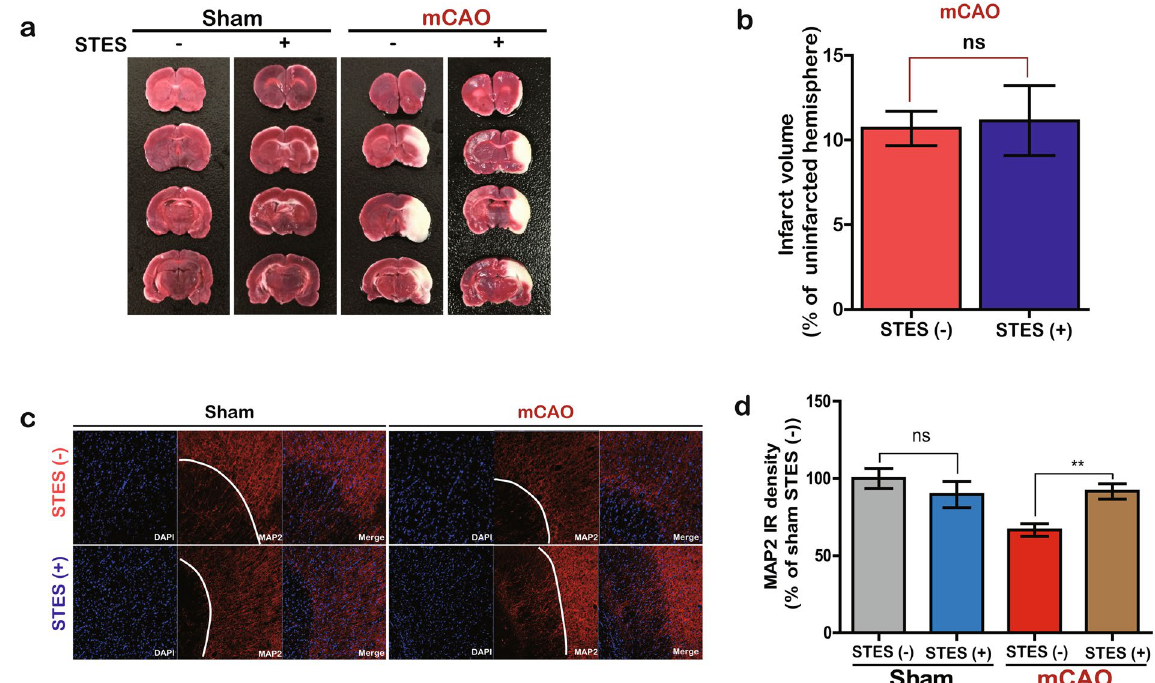
Figure 4. Infarct volume and histological analysis. ( a ) TTC staining of the brains in each group. Nonischemic areas appear red, and ischemic areas appear white. ( b ) Quantitative analysis of the cerebral infarct volume in each mCAO group (mCAO STES( +) and mCAO STES(-)). The bar graph reflects the infarct volume in each group. Neurological deficits were determined by stereological analysis with the ImageJ program. ( c